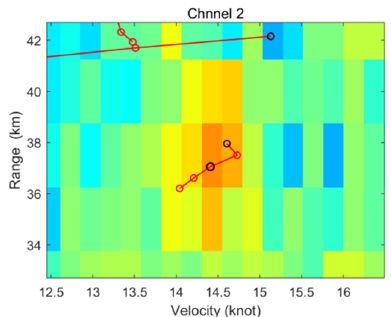
Figure 28. RD images of T1 during the period with uniform linear motion before P1.